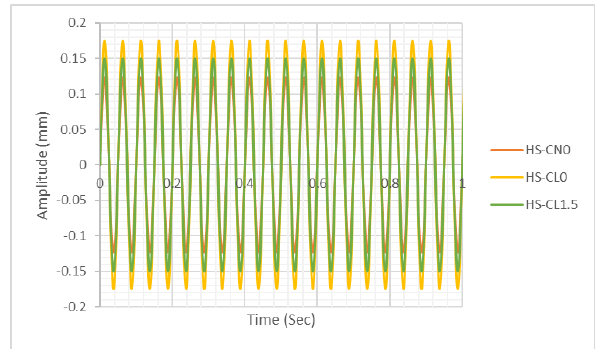
Figure 8: Vibration-time history under harmonic load with 20Hz frequency